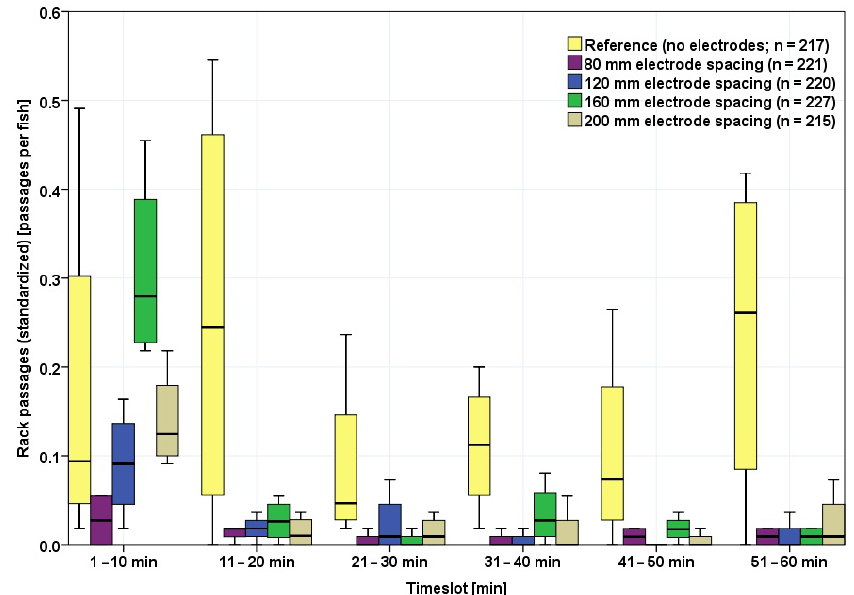
Figure 4. Standardized rack passages (recorded rack passages/stocked individuals in experiment) during time slots of 10 min for all five setups (each N = 4). Boxplots include representative statistic measures: minimum, first quartile, median, third quartile and maximum. Number of participating individuals per setup and four trials (N = 4) is denoted as